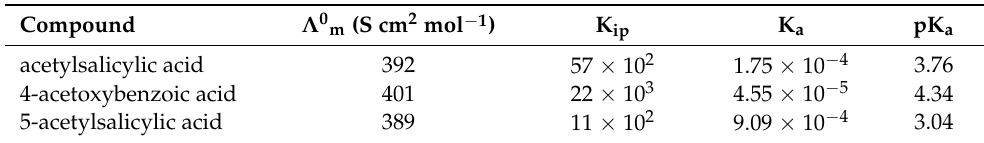
Figure 2. Conductance measurements of acetylsalicylic acid (aspirin), 4-acetoxybenzoic acid and 5-acetylsalicylic acid in water at 298.15 K. Table 2. Λ 0 m , K ip , K a and pK a values for acetylsalicylic acid, 4-acetoxybenzoic acid and 5- acetylsalicylic acid in water at 298.15